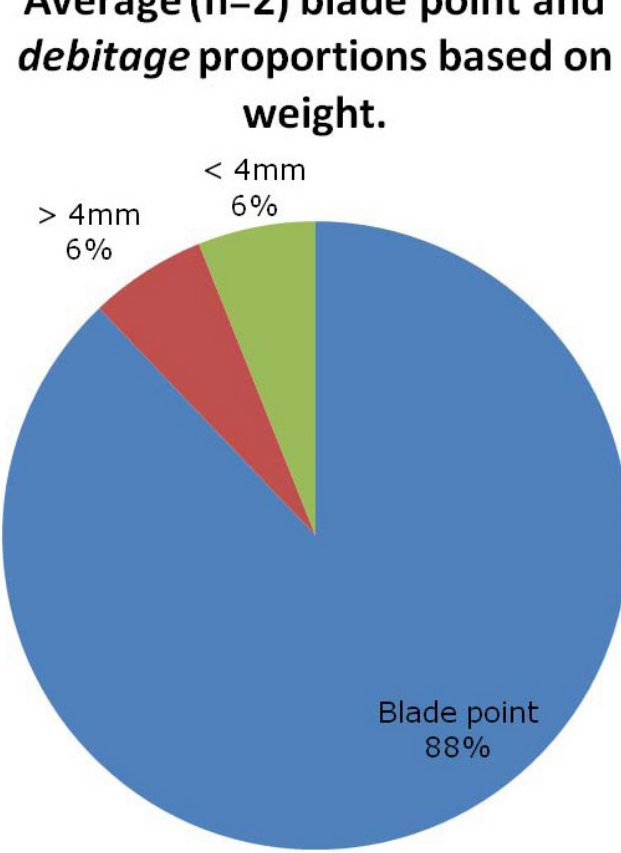
Figure 3. Average weight of blade-point in relation to debitage as a